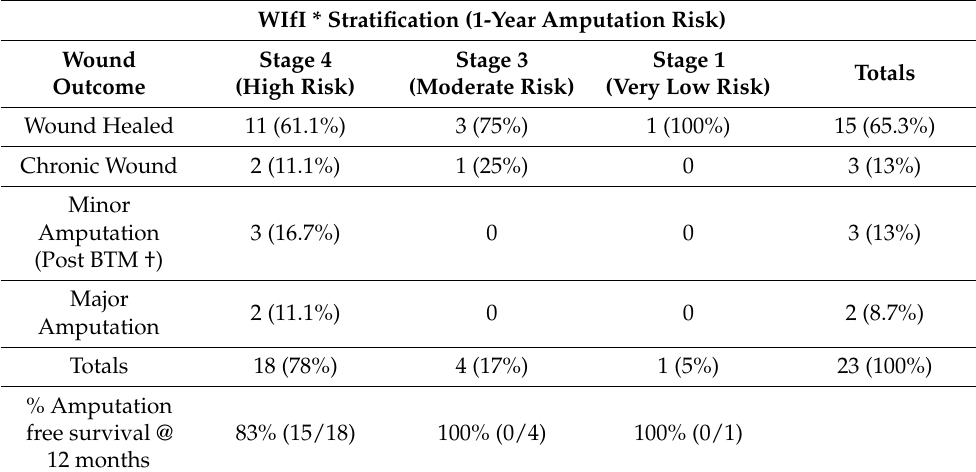
Table 2. WIfI * stratification versus outcomes at 12 months post-BTM †